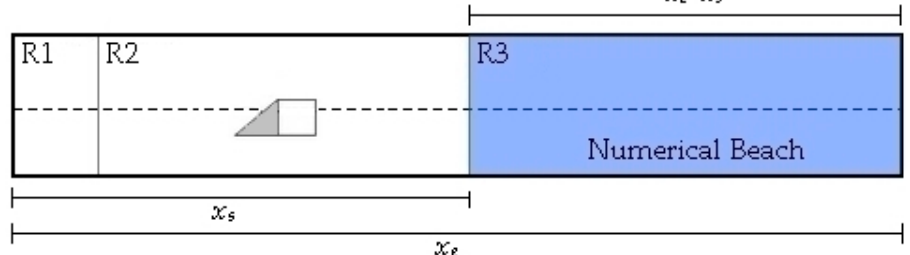
Figure 6. Schematic representation of the computational domain regions. The R1 region was discretized with an irregular mesh composed by triangles of side ∆ x = 0.3 m, according to Kisner et al. [47]. The R2 region was discretized with a structured mesh, as in Gomes et al. [44], having horizontally 125 computational cells per wavelength defined by a mesh independence test. The R3 region was discretized with quadrilaterals of side ∆ x = 0.5 m, as indicated by Saincher and Banerjee [48]. Figure 7 illustrates the mesh adopted for the computational domain, detailing each mentioned region.